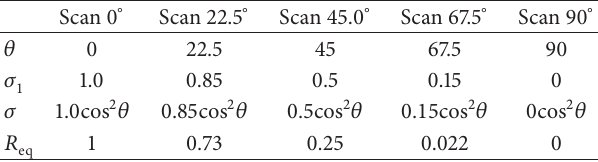
Table 2: Modeled conductivity of the first ply.